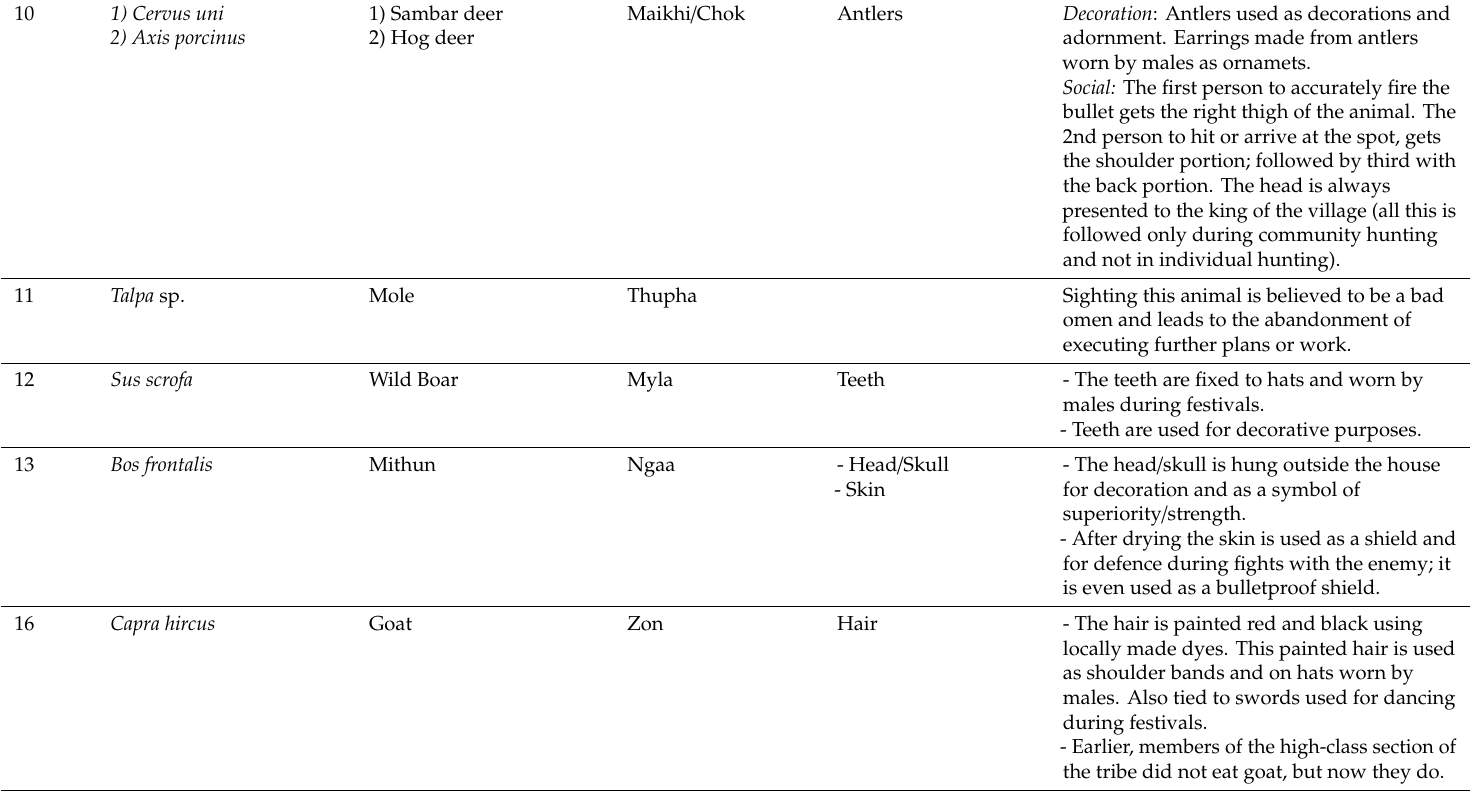
Antlers Decoration : Antlers used as decorations and adornment. Earrings made from antlers worn by males as ornamets. Social: The first person to accurately fire